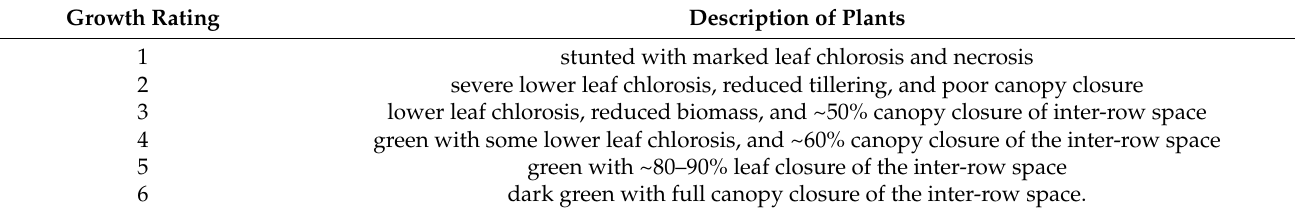
Table 3. Rating system of plant growth and symptoms at late stem elongation (Z35) in Experiment 4. Growth Rating Description of